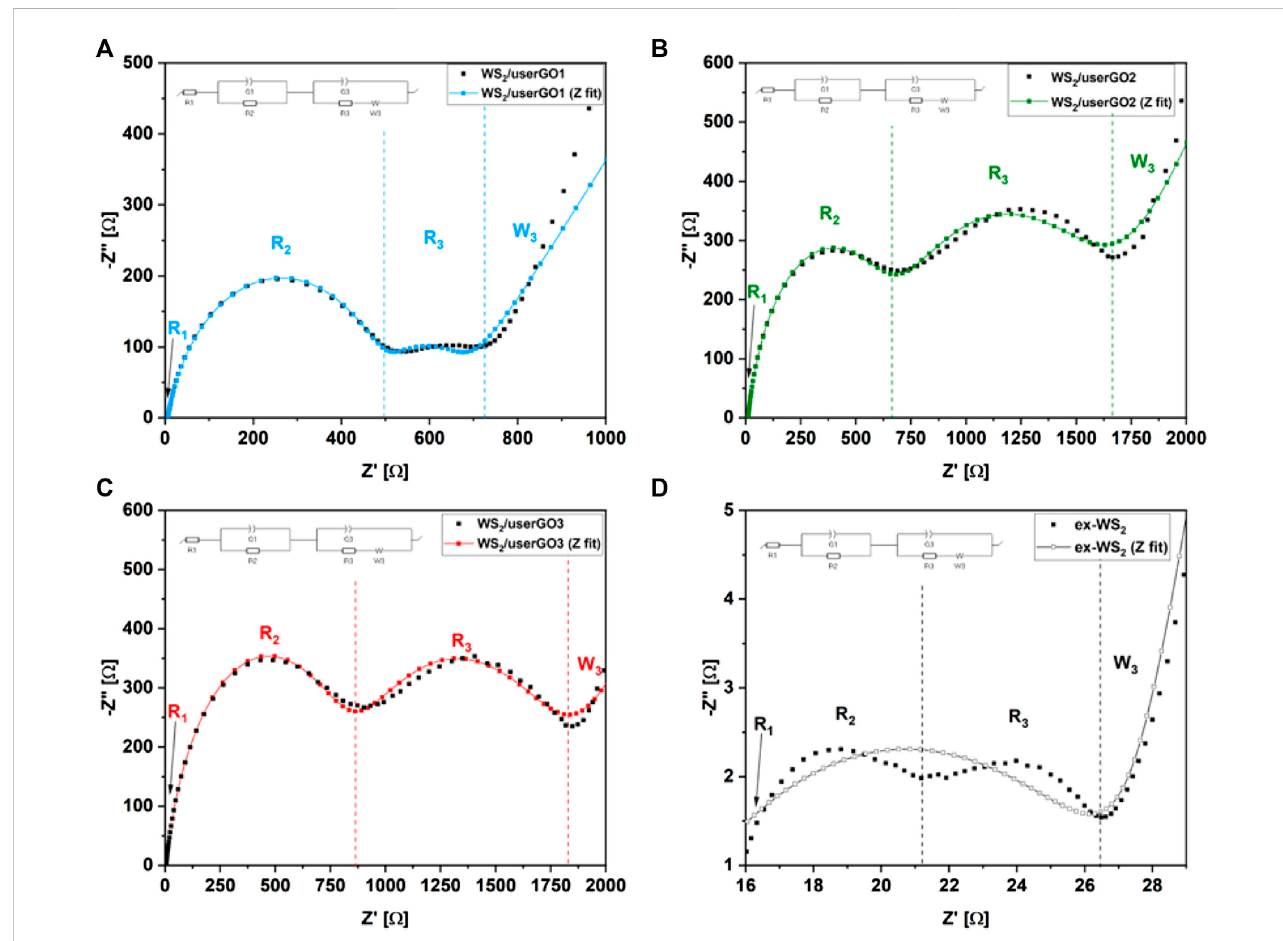
FIGURE 9 Nyquistplotsof (A) WS 2 /userGO1, (B) WS 2 /userGO2, (C) WS 2 /userGO3,and (D) ex-WS 2 afterdischarge/chargecyclesandtheequivalentcircuitdiagrams of the